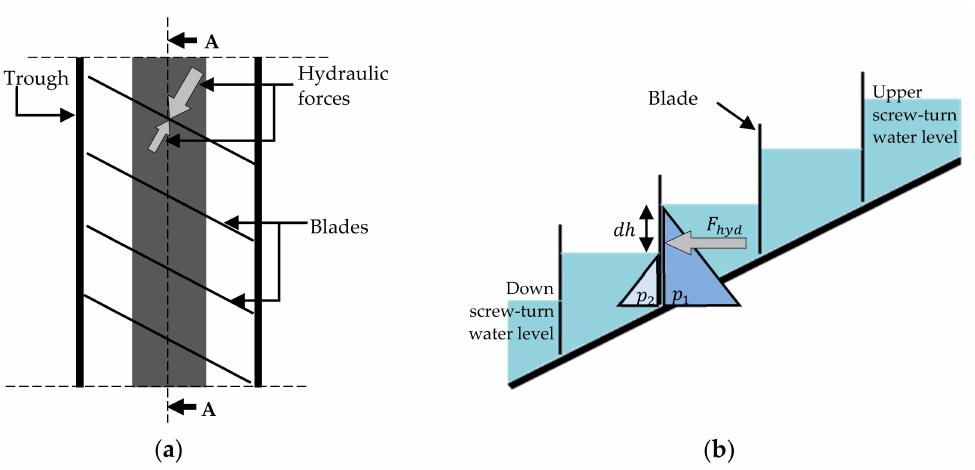
Figure 2. Forces acting on idealized Archimedean screw blade. ( a ) plan view ( b ) side view of cross-section on plane